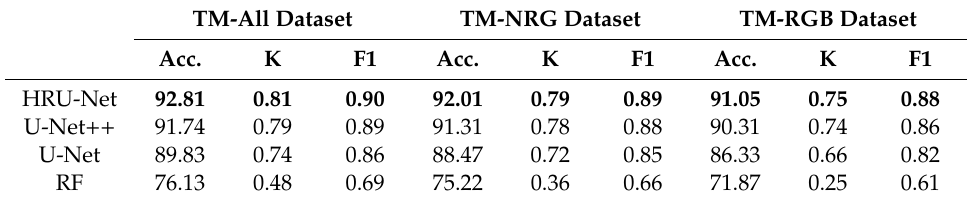
Table 5. Extraction accuracy of HRU-Net, U-Net ++ , U-Net, and